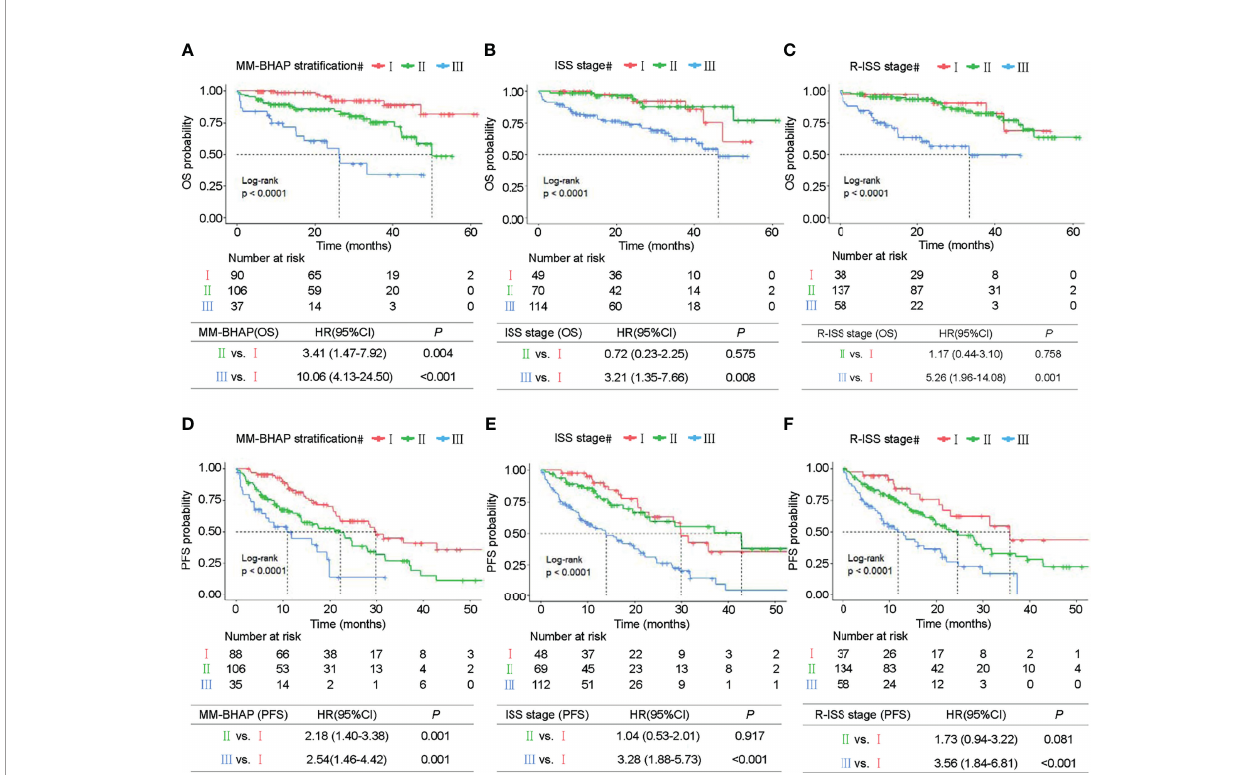
FIGURE 3 | Kaplan – Meier survival curves in the development cohort. OS of MM patients was strati fi ed by the MM-BHAP strati fi cation (A) , ISS stage (B) , and R-ISS stage (C) . PFS was also classi fi ed by the three risk strati fi cations (D – F)